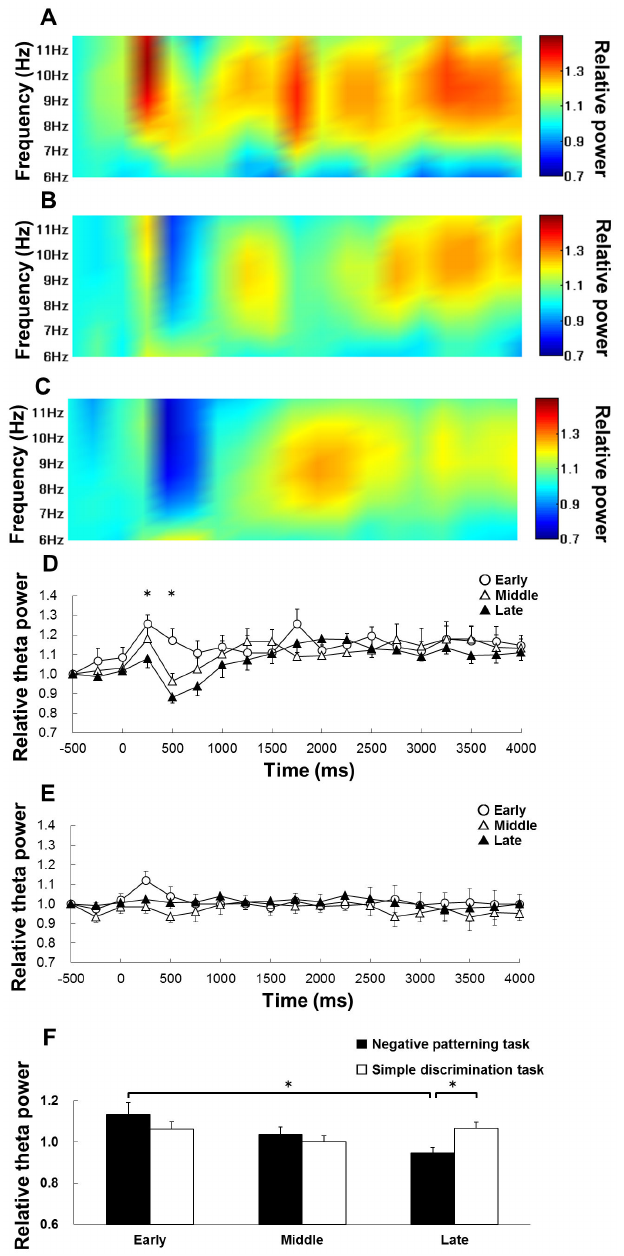
Figure 5. The change in theta power during the non-RFTs during each learning stage of the negative patterning task. Panel A shows the change in hippocampal theta activity along a time course during non-RFTs on the early stage, panel B shows theta activity on the middle stage and panel C shows theta activity on late stage of negative patterning task. The x-axis is time (ms) and the y-axis is frequency (Hz). In each panel, the period is from 500 ms before stimulus onset to 4000 ms after stimulus onset. The period was divided into 19 sub-periods of 250 ms each. The mean hippocampal theta power during 500 ms before stimulus onset was counted as the -500-ms period (no stimuli were present and no rats pressed the lever during this period) and the relative theta power calculated for each period was normalized to that during the -500-ms period (relative theta activity of each period = theta power of each period/theta power at the -500-ms period). Panel D contains a comparison of the mean (± S.E.M.) relative hippocampal theta activity at 6–12 Hz among each learning stage (early, middle, and late) throughout the time course of the experiment during non-RFT of the negative patterning task (*: p < 0.05). Panel E contains a comparison of the mean (± S.E.M.) relative hippocampal theta activity at 6–12 Hz among each learning stage (early, middle, and late) throughout the time course of the experiment during non-RFT of the simple discrimination task. doi: 10.1371/journal.pone.0070756.g005 PLOS ONE |